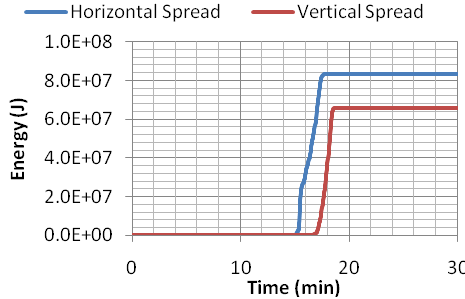
Fig. 16. Time-history of plastic dissipation energy in 10-storey frame.